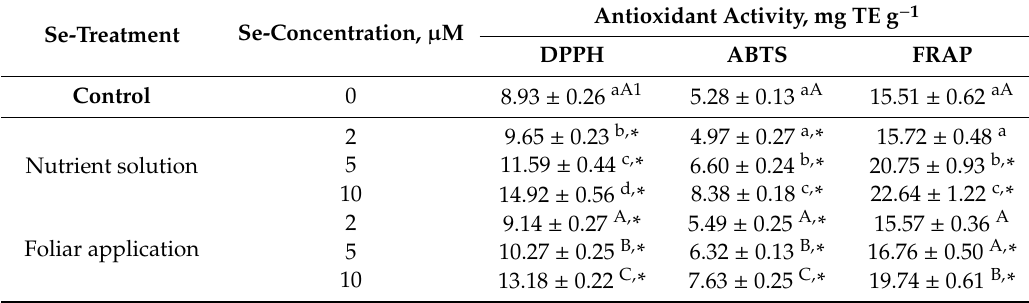
Table 2. E ff ect of type and concentration of Se application on antioxidant activity of basil leaf extracts determined by the DPPH, ABTS and FRAP